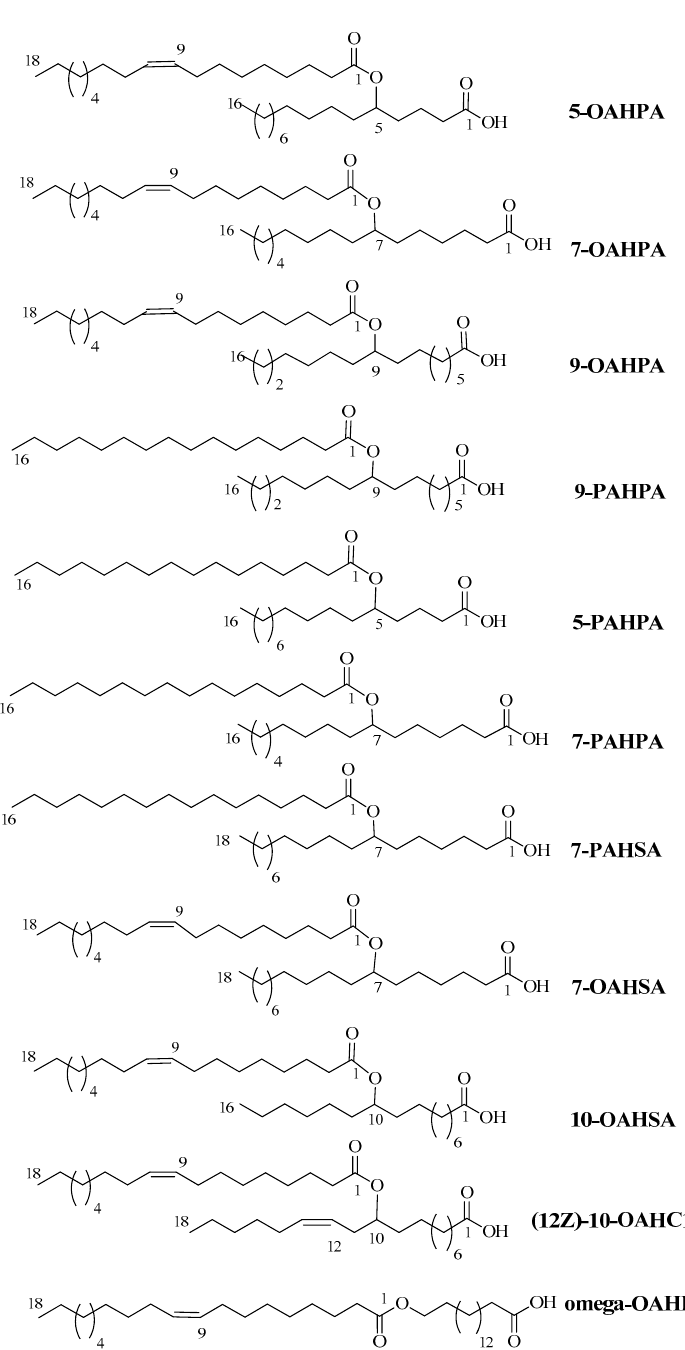
1 Figure 1. Molecular formula, mass, and names of the fatty acid esters of hydroxy fatty acids (FAHFAs)